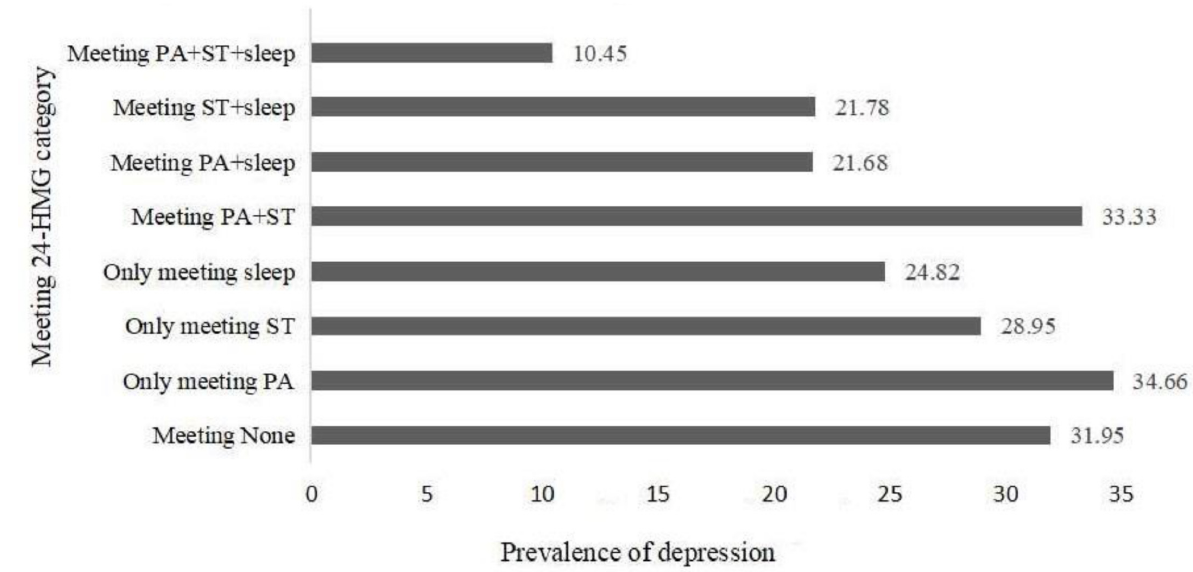
Figure 1. Prevalence of anxiety in different groups of